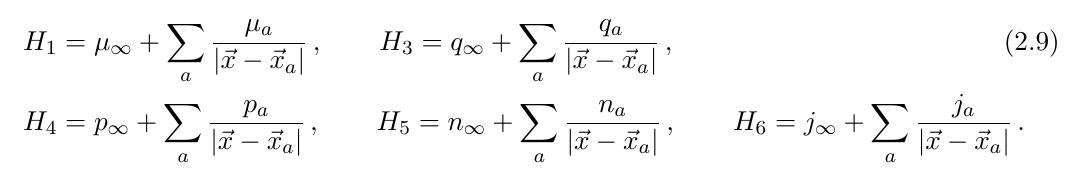
Figure 1 . A multi-string con(cid:12)guration in 6d. The distances between the strings are constrained by the integrability equations (2.22). The base here is a 3-center Gibbons-Hawking space. background is then given in terms of (cid:12)ve additional generic harmonic functions on R 3 (see [17] for more